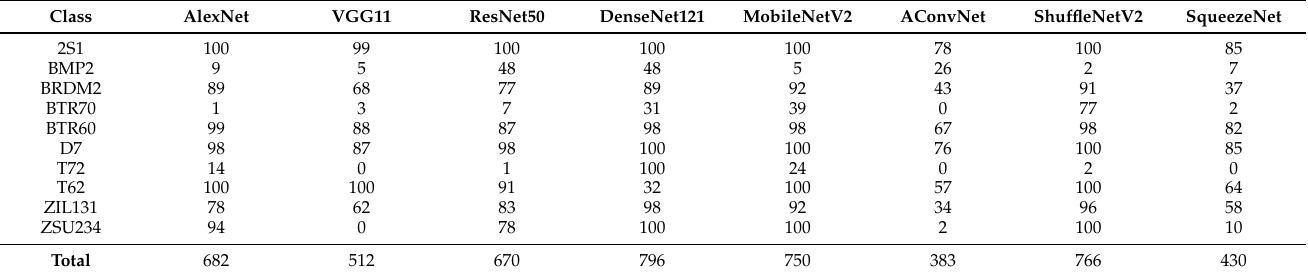
Table A5. Robustness test of DF-UAP with MobileNetV2 as substitute model.